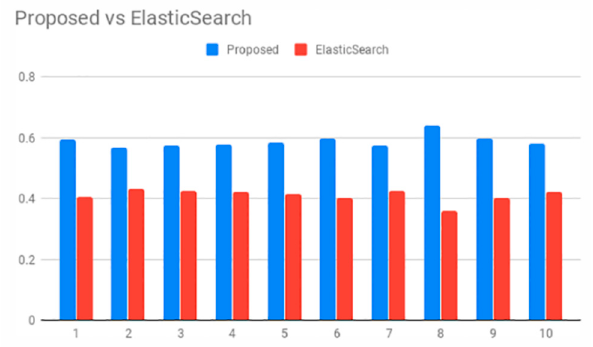
Figure 12. Test results of 10-fold cross validation between the GA10 algorithm of ElasticSearch and the proposed system.